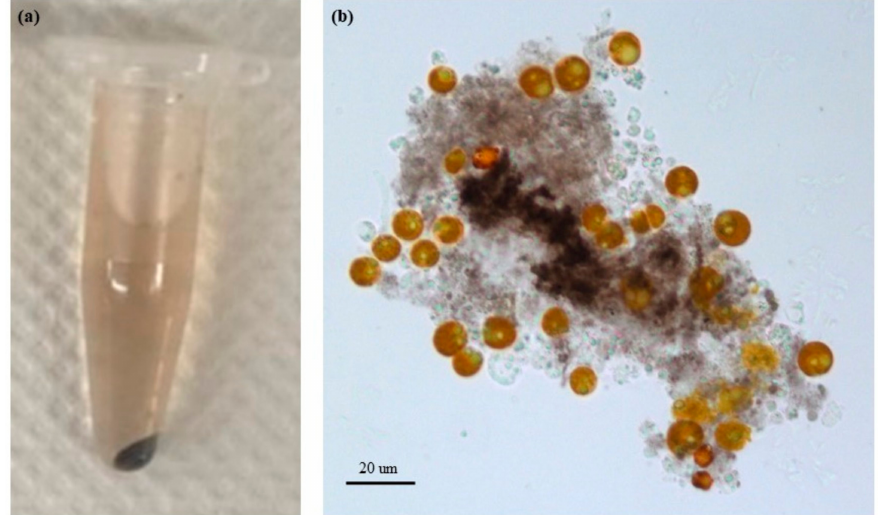
Figure 8. Observation of the collected black precipitate with the naked eye and with a microscope. ( a ) Black pigment released from S. flexibilis was collected from the bottom of a 1.5 mL centrifuge tube; ( b ) the black pigment entangled with Symbiodiniaceae (brown spheres) as observed under